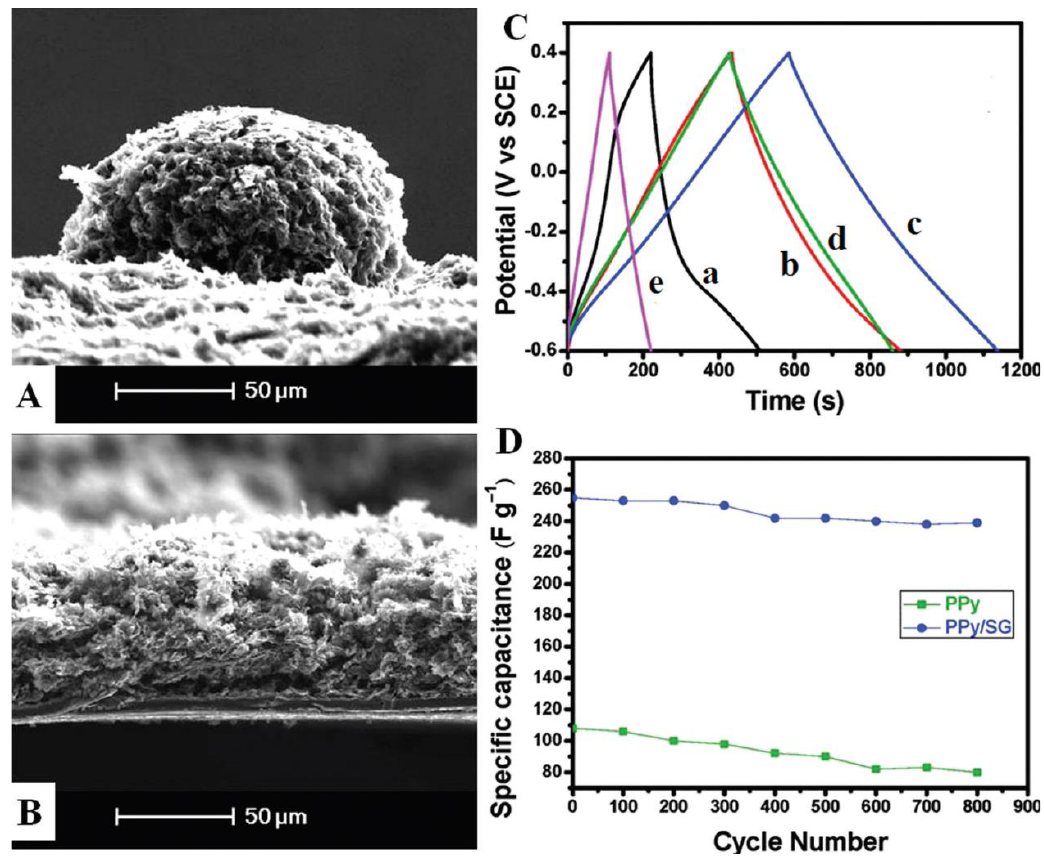
Figure 3. ( A ) SEM micrograph of PPy/SG nanocomposite formed at 1 C cm −2 . ( B ) Image of the nanocomposite deposited at 2 C cm −2 . ( C ) Charge/discharge curves of nanocomposites grown at 0.5 (a), 1.0 (b) 2 (c), and 4 C cm − 2 (d), respectively, and (e) SG film in the aqueous solution of 1 mol L − 1 KCl. ( D ) Cycling stability test of PPy and PPy/SG nanocomposites. Taken from [79]. Reprinted with permission from Ref. [79]. Copyright 2010 American Chemical